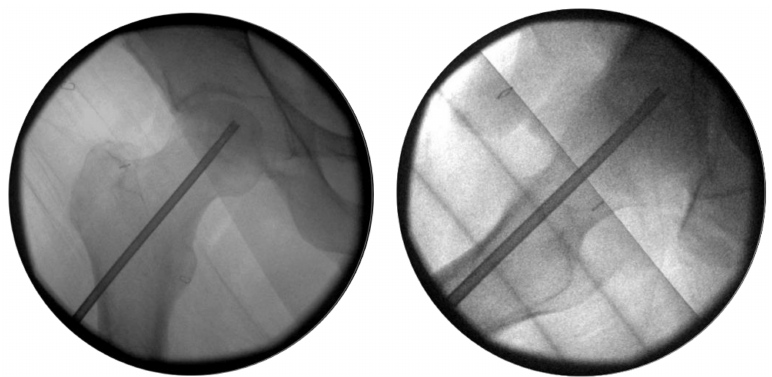
Figure 1. Intraoperative fluoroscopic images showing the drilling tunnel for implantation of cell therapy in anteroposterior (AP) (left) and lateral (right)